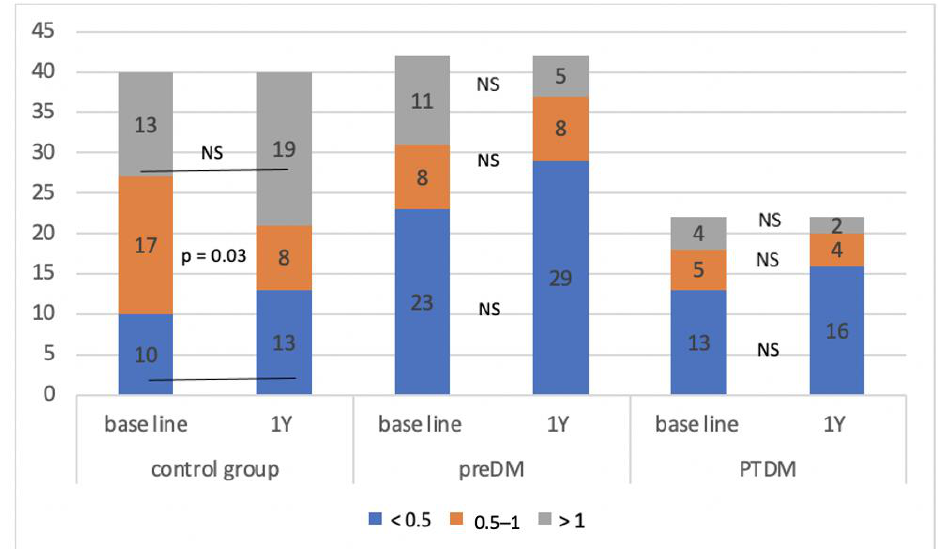
Figure 3. Change in the composition of the observed group according to the A/L ratio during the